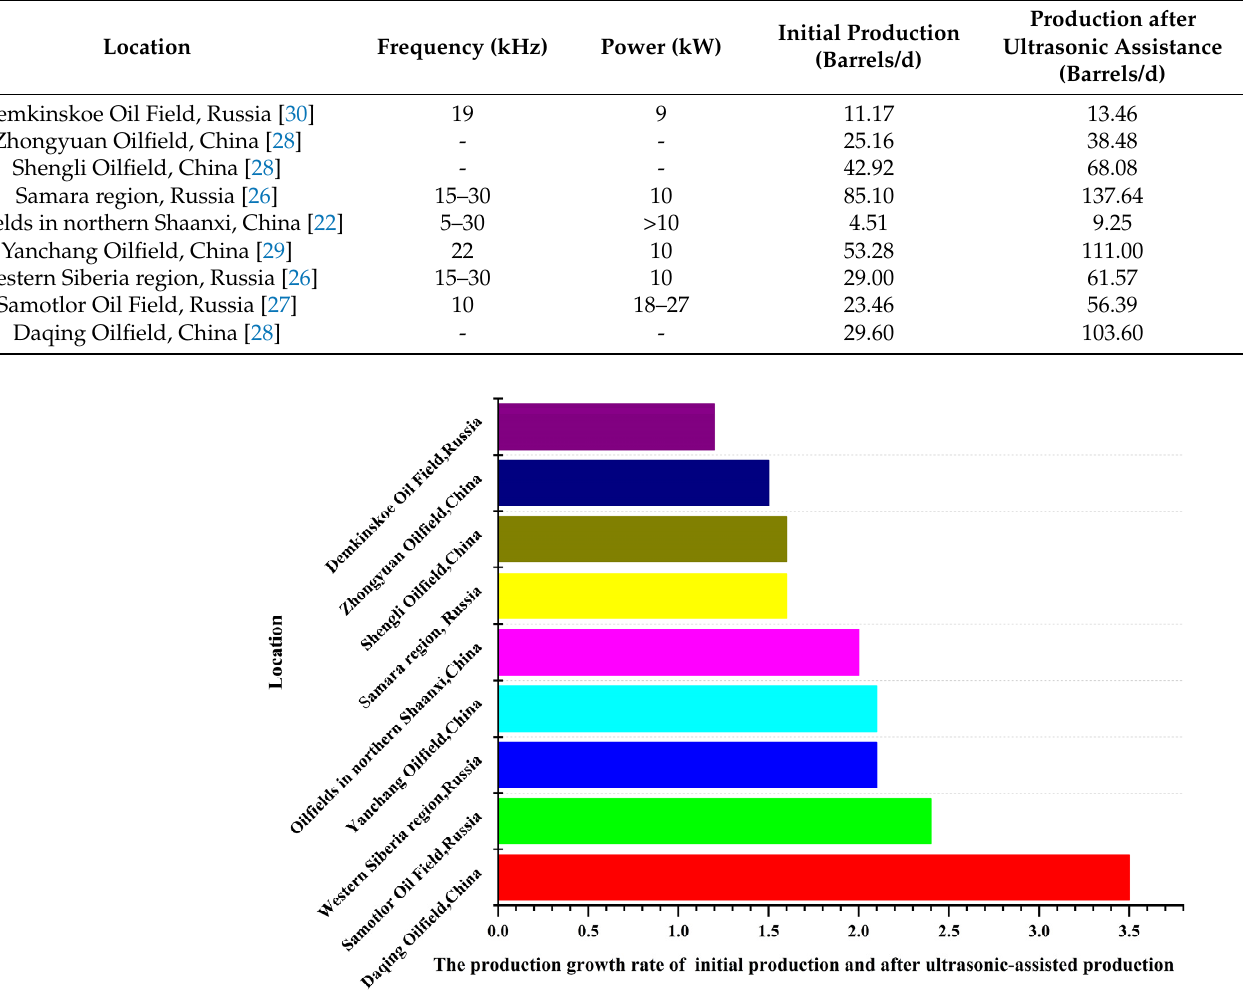
Figure 1. The production growth rate of initial production and ultrasonic-assisted production in different locations.